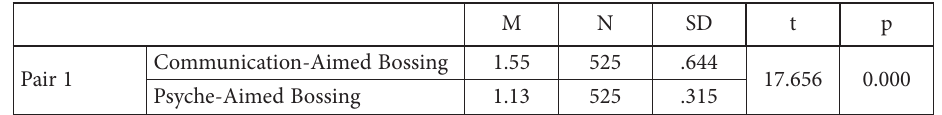
Table 6. Assessment of the BOSS methodology